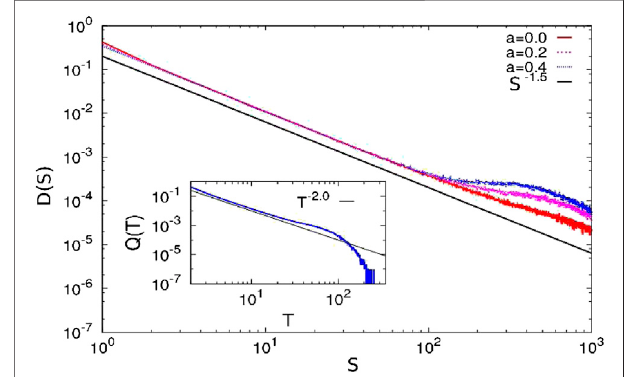
FIGURE 12 | The avalanche size distributions are plotted for zero and fi nite lower cutoffs for Model II. The distribution function isa power law with an exponent value of 1 . 50 ± 0 . 01, which is also our estimate from scaling arguments. Inset: The distribution of avalanche duration is plotted for Model II. This also shows a power law decay with an exponent value of 2 . 00 ± 0 . 01. From